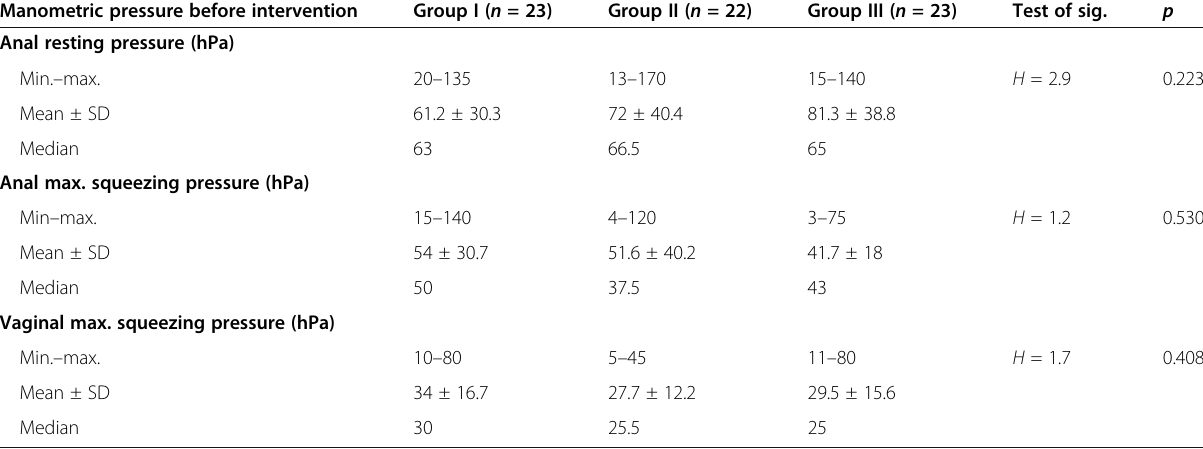
Table 1 Comparison of the manometric pressure assessment in the three groups before the intervention Manometric pressure before intervention Group I ( n = 23) Group II ( n = 22) Group III ( n = 23) Test of sig.